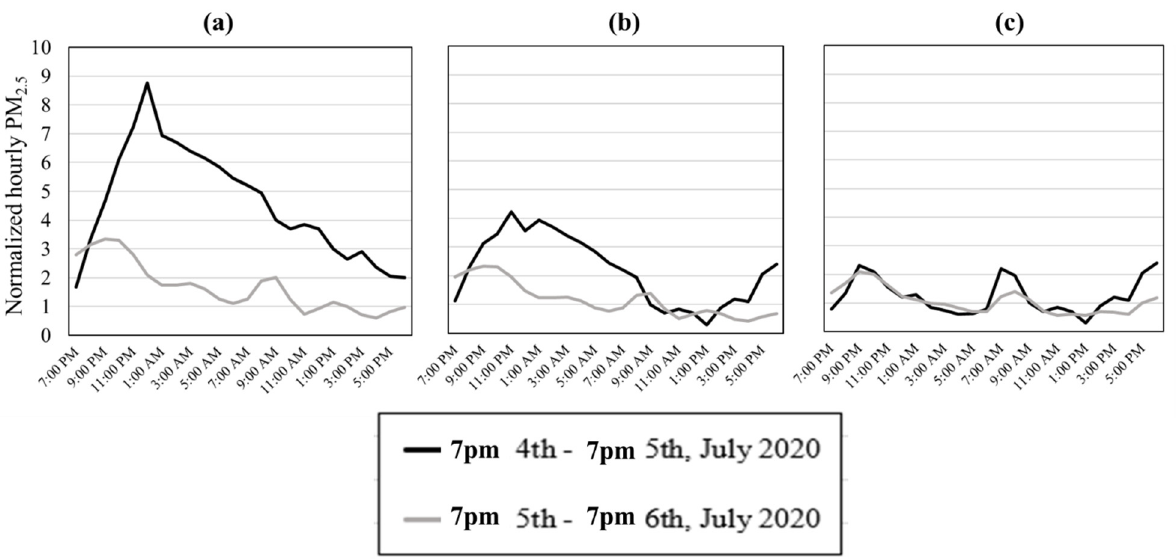
Figure 1. Examples of hourly average PM 2.5 concentrations from 7:00 p.m. on July 4th to 7:00 p.m. on July 5th 2020 according to three different scenarios observed in ( a ) Los Angeles County (high impact), ( b ) Orange County (moderate impact), and ( c ) Riverside County (low impact).